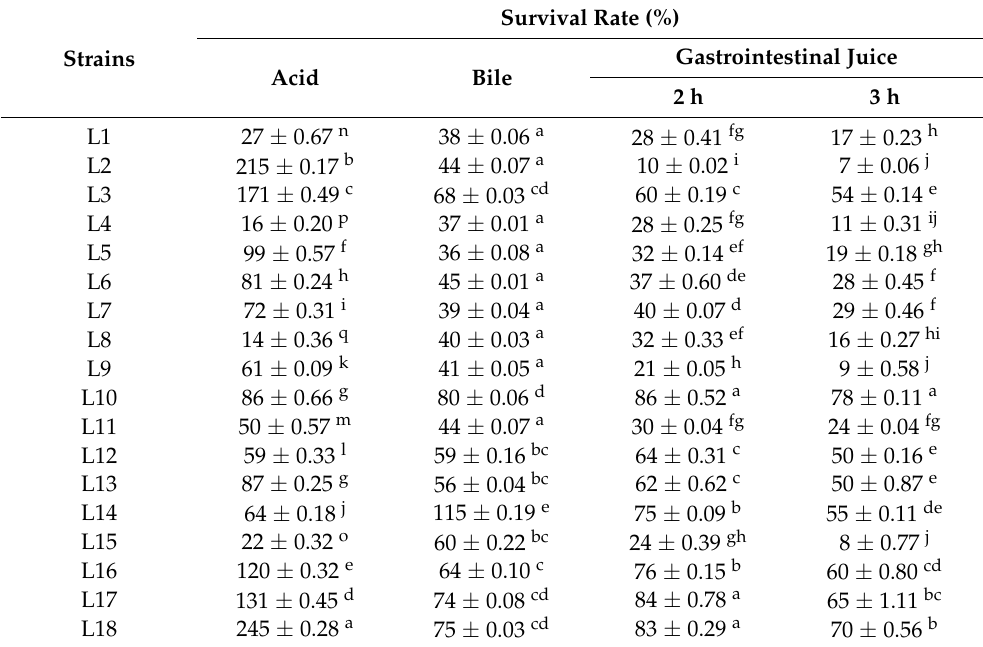
Table 2. Acid, bile, and gastrointestinal juice tolerance of 18 strains. Strains